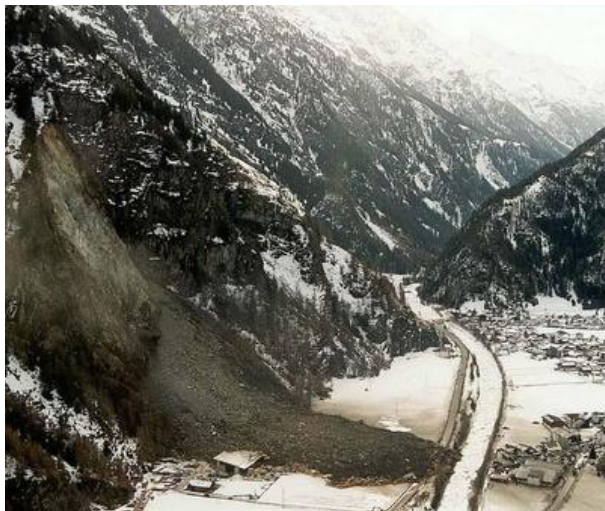
Fig. 1. Rockfall of Huben (Austria) that destroyed a sawmill on 11 March 1999. The rockfall originated from the over-steepened valley flank of the ¨Otztal far below the permafrost reaches. Photo- graph by die.wildbach, taken from